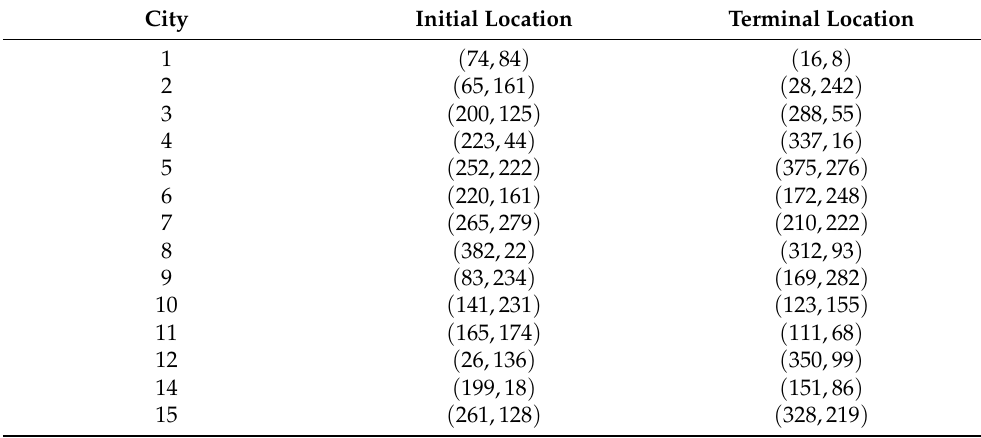
Table 6. The initial location and the terminal location of 15 cities.